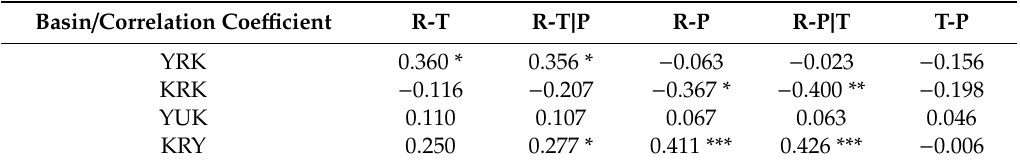
Table 4. Pearson correlation coe ffi cients and partial correlation coe ffi cients between annual runo ff (R) and mean air temperature (T) and precipitation (P) in four basins. Basin / Correlation Coe ffi cient R-T R-T | P R-P R-P | T T-P YRK 0.360 * 0.356 * − 0.063 − 0.023 − 0.156 KRK − 0.116 − 0.207 − 0.367 * − 0.400 ** − 0.198 YUK 0.110 0.107 0.067 0.063 0.046 KRY 0.250 0.277 * 0.411 *** 0.426 *** −